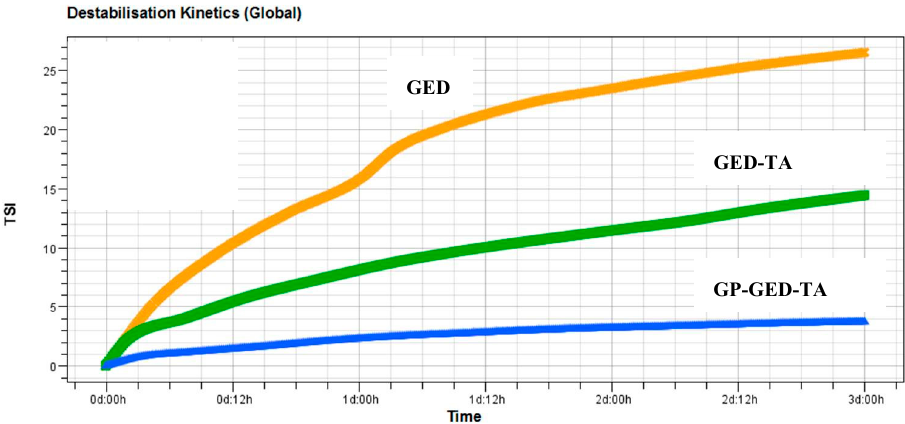
Figure 6. Global turbiscan stability index (TSI) of O / W emulsions generated by different stabilizing agents.